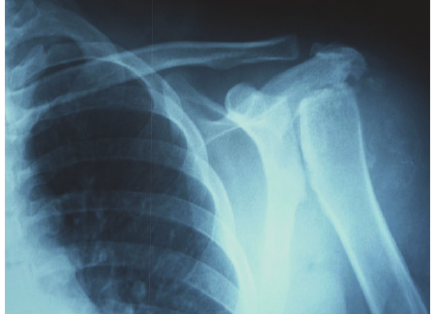
Figure 2: Radiography of the left shoulder revealed severe destruc- tive changes with loss of bone and joint architecture, consistent with a Charcot joint.